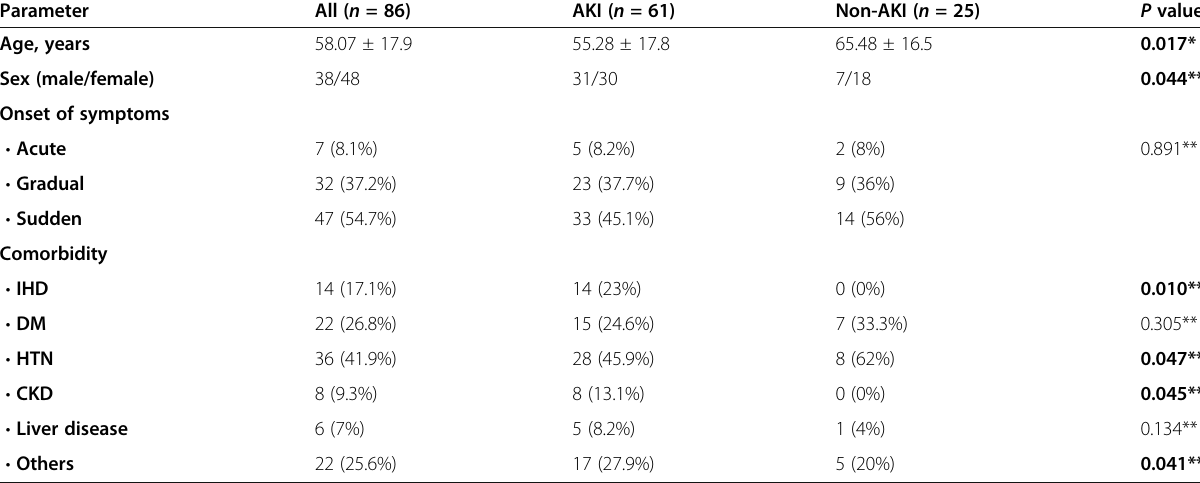
Table 1 Baseline Patients characteristics of the study groups